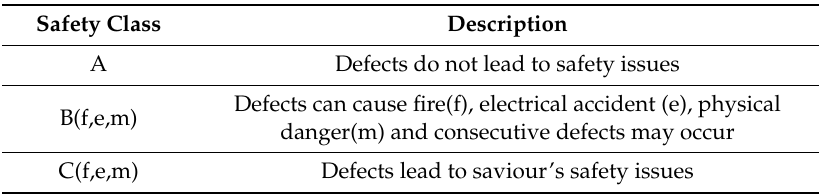
Table 1. Types of safety classes.